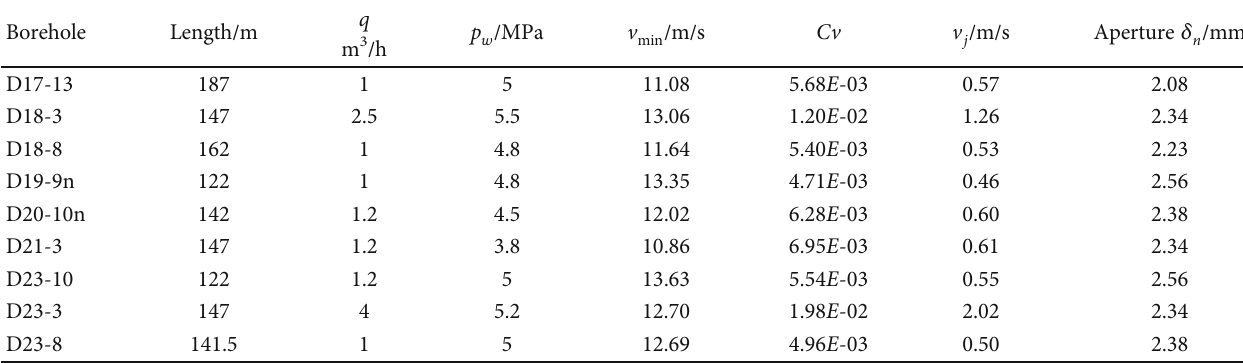
Table 3: Monitored data, velocity coe ffi cient, and apertures of typical boreholes.